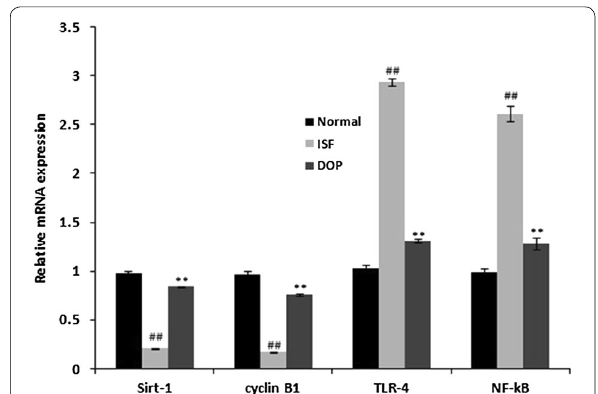
Fig. 7 Desoxyrhapontigenin ameliorates the mRNA expression of TLR-4, NF-kB, cyclin B1, and Sirt-1 in the brain tissues of rats with anaesthesia-induced neuronal injury. Mean